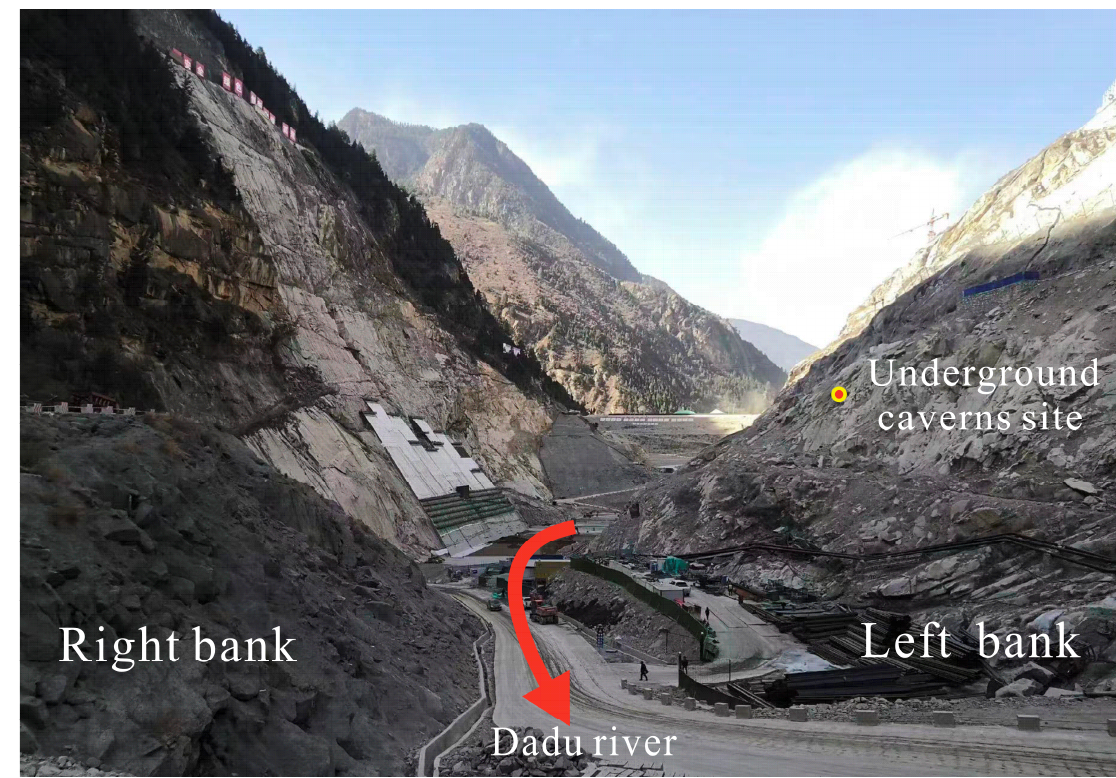
Figure 3. Dam site of Shuangjiangkou Hydropower Station. Table 2. The mechanical parameters.